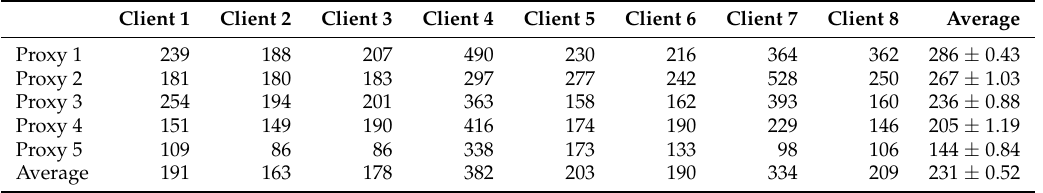
Table 6. Average MAE obtained by the baseline algorithm for each client/proxy pair, with a 40% density. Values are in